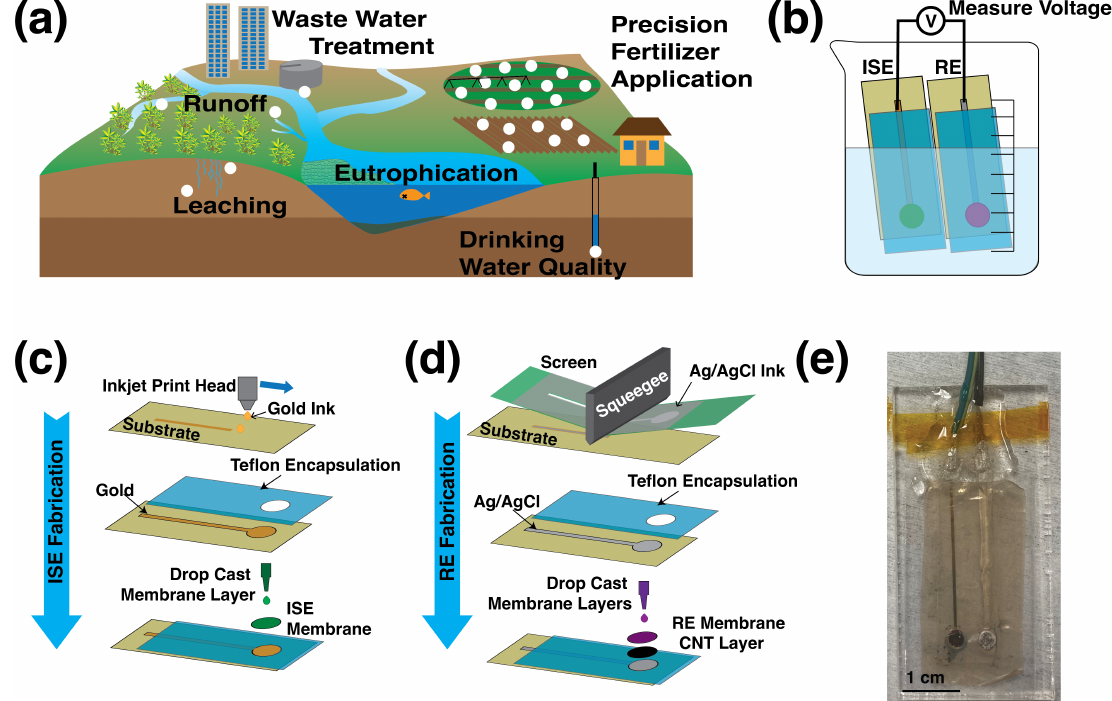
Figure 1. ( a ) Printed sensors could be widely deployed to map nitrate from fertilizer application to runoff. ( b ) The potential difference between the printed ion-selective and printed reference electrodes is determined by the nitrate concentration in the solution, and this potential is read as the sensor’s output. ( c ) Ion-selective electrodes are made by inkjet printing gold onto a substrate, and encapsulating the trace with a teflon tape. The membrane solution is drop-cast onto the exposed area of the electrode. ( d ) Reference electrodes are made by screen printing Ag/AgCl ink onto the substrate, and the trace is encapsulated with teflon. The carbon nanotube transducing layer is drop-cast first, followed by the PVB/salt membrane. ( e ) A fully printed sensor mounted on acrylic backing and with wires attached is ready for use in soil